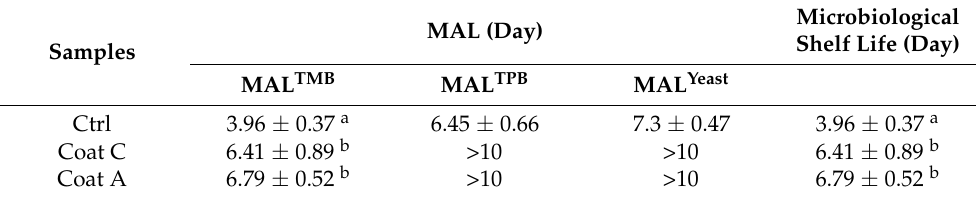
Table 1. Microbial acceptability limit (MAL) of coated and uncoated prickly pears during storage at 4 ◦ C.